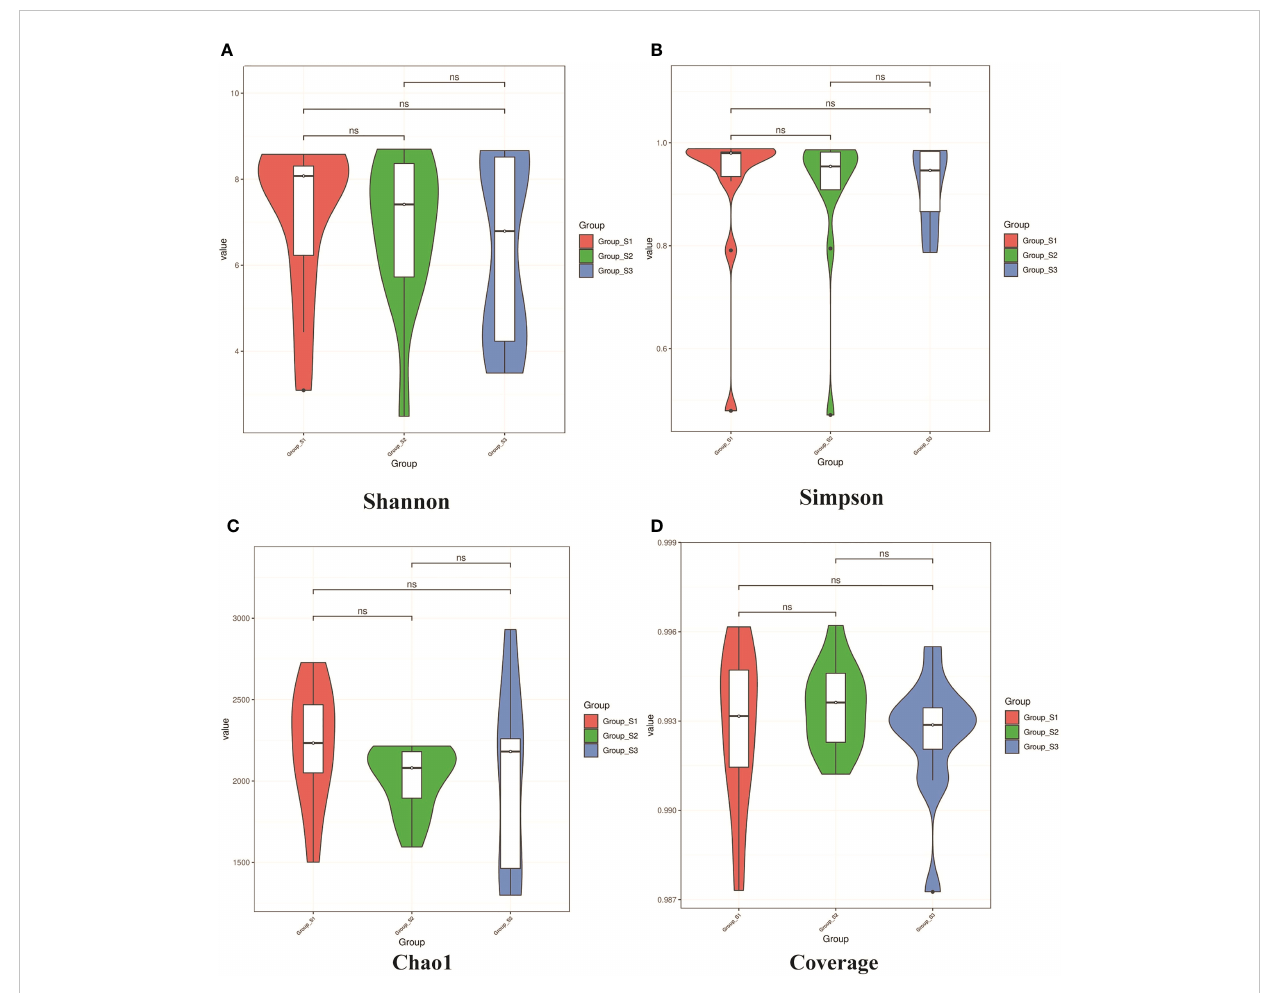
FIGURE 5 Violin diagrams of a -diversity on Shannon, Simpson index, Chao I and Coverage indices from each BMI group. (A, B) Violin diagrams of microbiota on Shannon and Simpson indices respectively, representing the diversity of microbiota within the group. (C) Violin diagram of microbiota on Chao1 indice, representing the richness of microbiota within the group. (D) Violin diagram of microbiota on Goods coverage indice, representing the sequencing depth of microbiota within the group.(K-W test, ns: P <0.05, there were no statistical differences between different